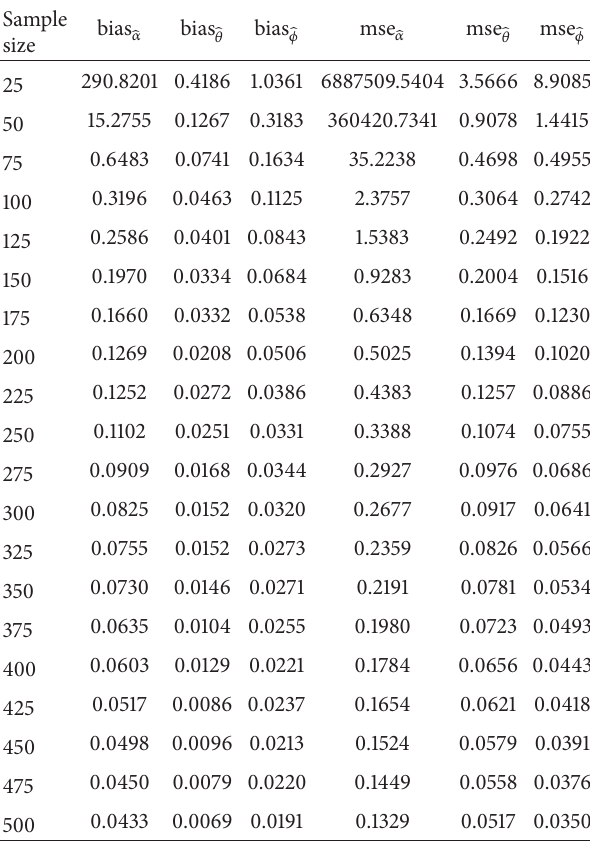
Table 3: Monte-Carlo simulation results of the parameter estimates and standard errors of the EG type-2 distribution with parameters: 𝛼 = 1.50 , 𝜃 = 1.50 , and 𝜙 = 1.50 for different sample sizes.